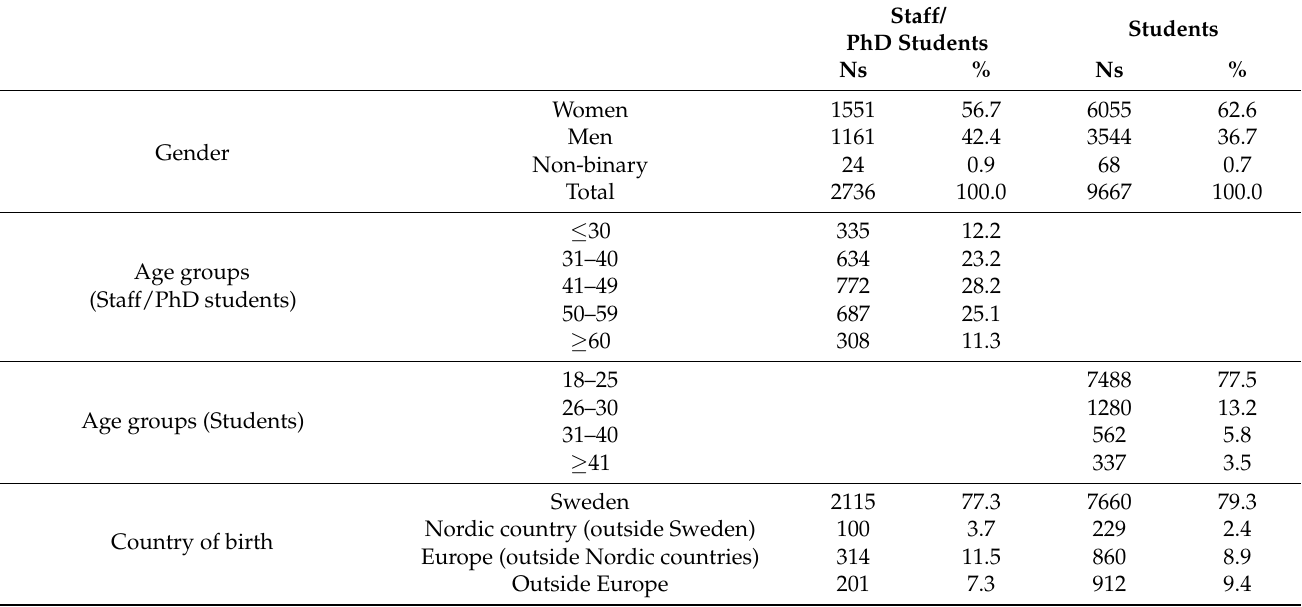
Table 1. Participants in the Tellus survey, Lund University, Sweden, 2020.